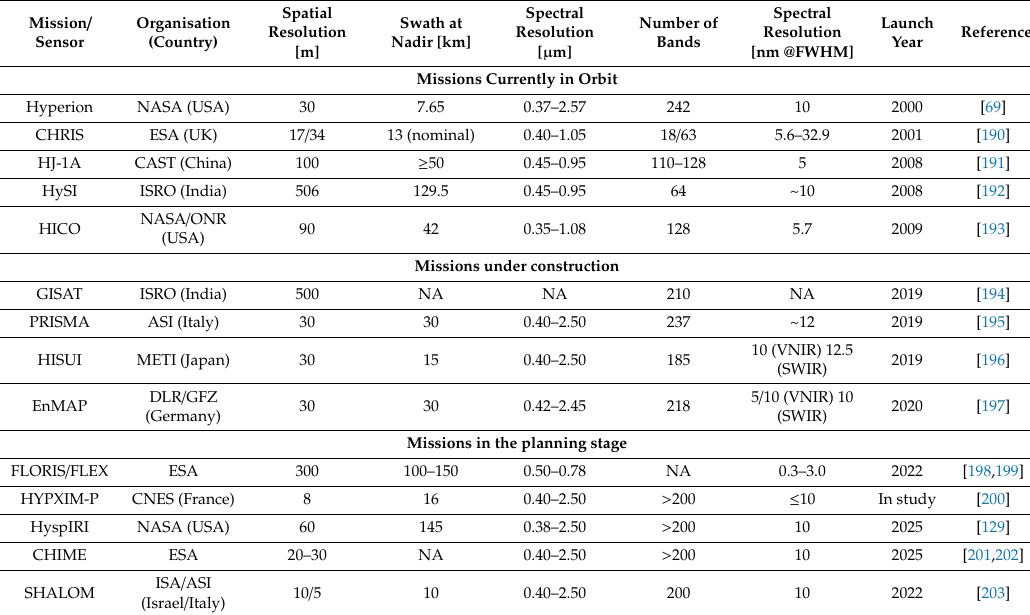
Current and future important spaceborne hyperspectral missions with their sensor characteristics deriving soil characteristics and their traits (modified after